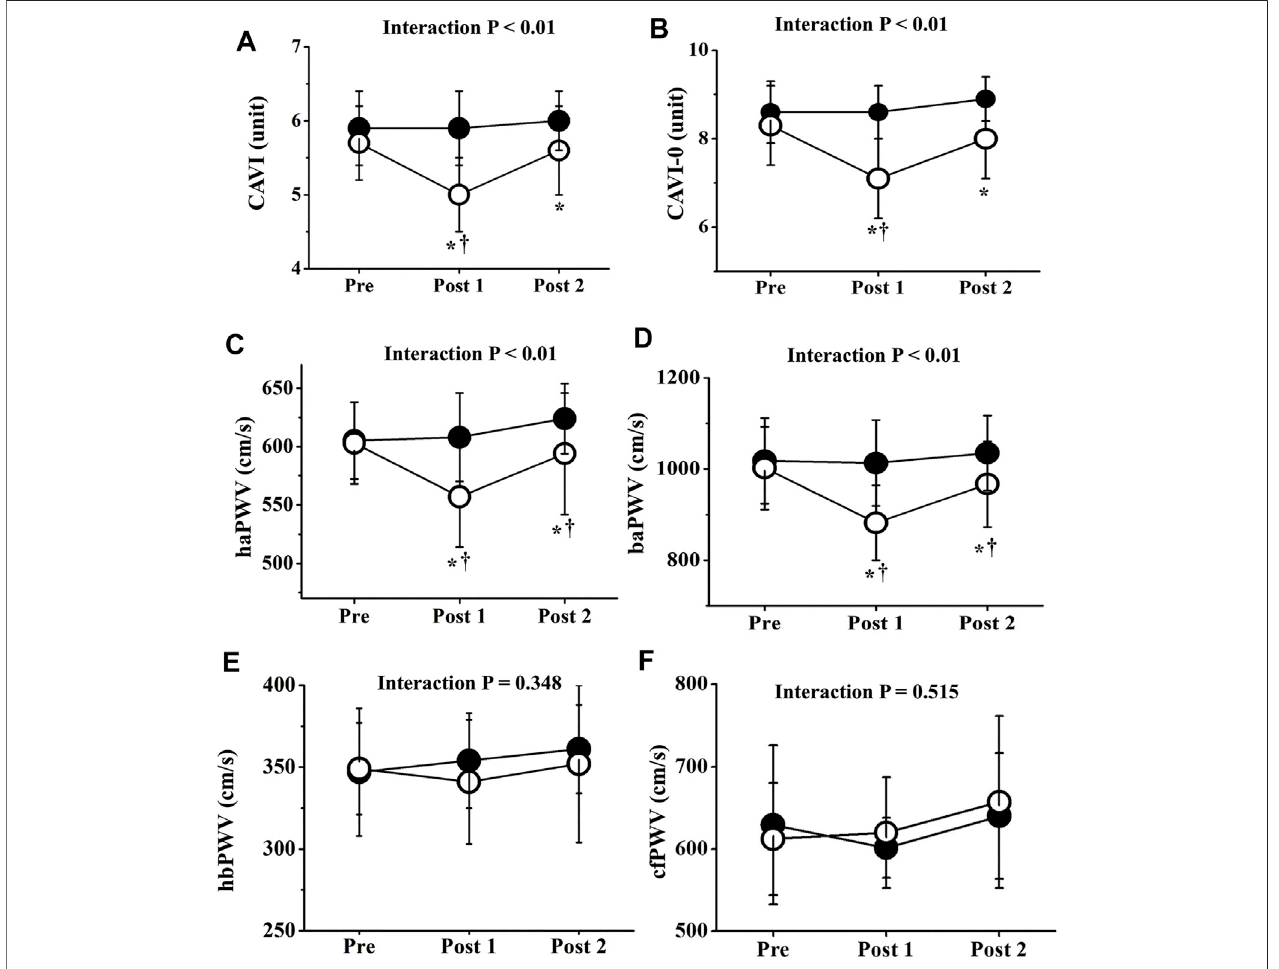
FIGURE 4 | Temporal changes in arterial stiffness parameters. CAVI (A) , CAVI0 (B) , haPWV (C) , baPWV (D) , hbPWV (E) , and cfPWV (F) are shown. Filled circles (cid:129) ( ), control resting trial; open circles ( ○ ), electrical stimulation trial; CAVI, cardio-ankle vascular index; CAVI0, cardio-ankle vascular index 0; haPWV, heart-ankle pulse wave velocity; baPWV, brachial-ankle pulse wave velocity; hbPWV, heart-brachial pulse wave velocity; cfPWV, carotid-femoral pulse wave velocity. Other abbreviations are the same as in Figure 1 . p p < 0.01 vs. CT; † p < 0.01 vs. Pre. Data are given as mean ± SD.